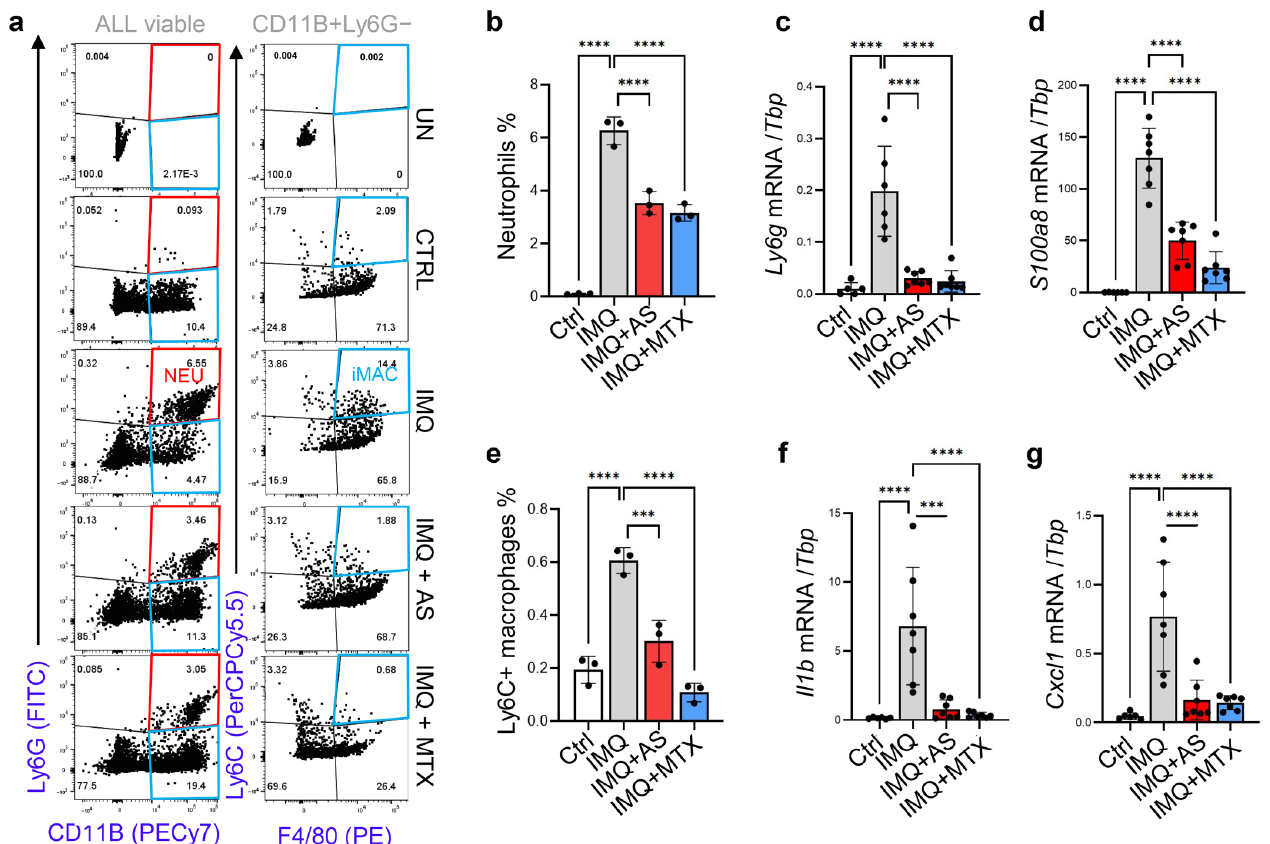
Figure 3. Administration of aluminum salt reduced the recruitment and activation of myeloid cells in the IMQ-induced psoriasis model: ( a ) FACS plots showing the presence of neutrophils (CD11B+Ly6G+) and inflammatory macrophages (CD11B+Ly6G-F4/80+Ly6C+); ( b ) Quantified FACS results showing the percentage of neutrophils in each group ( n = 3/group); ( c , d ) qRT-PCR analysis of the mRNA expression levels of Ly6g and S100a8 (ratios to HK gene Tbp were shown, n = 6~7/group); ( e ) Quantified FACS results showing the percentage of inflammatory macrophages in each group ( n = 3/group); ( f , g ) qRT-PCR analysis of the mRNA expression levels of Il1b and Cxcl1 (ratios to HK gene Tbp were shown, n = 6~7/group). All error bars indicate me an ± SEM, and statis- tical analysis was performed by one- way ANOVA analysis with Dunnett -corrected multiple com- parisons. *** p < 0.001, **** p < 0.0001.